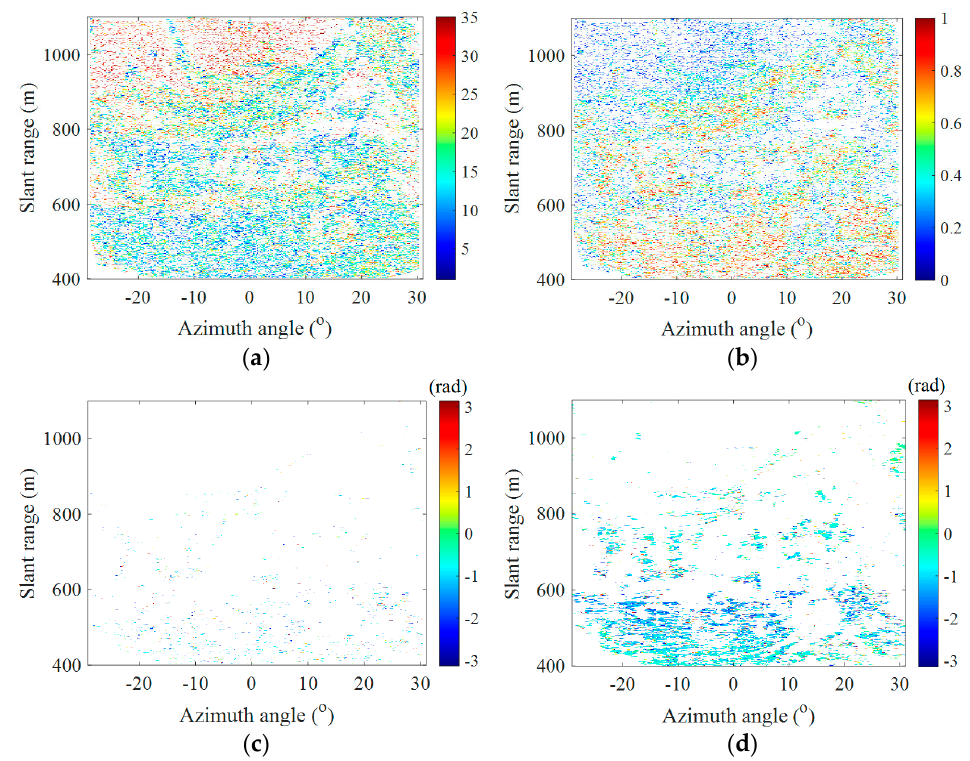
CS (candidate set of the distributed scat- Figure 14. ( a ) Statistically homogeneous pixel map of Figure 14. ( a ) Statistically homogeneous pixel map of CS DS (candidate set of the distributed scatter- DS γ map of the distributed scatterers (DSs); ( c ) phase map of the selected terers); ( b ) coherence ers); ( b ) coherence γ DS map of the distributed scatterers (DSs); ( c ) phase map of the selected DSs after DS IM . DSs after coherence selection; ( d ) wrapped phase map of the HQPs based on coherence selection; ( d ) wrapped phase map of the HQPs based on IM 1–2 1-2